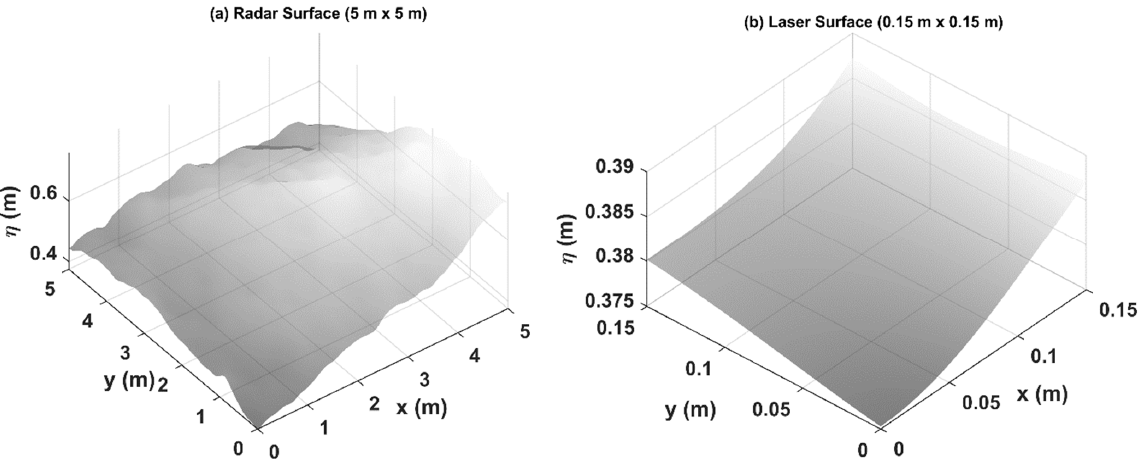
Figure 1. Examples of water surface regions simulated using linear (Fourier) numerical modeling approximately covered by the footprints of ( a ) the Radar (5 m × 5 m ) and ( b ) the Laser (0.15 m × 0.15 m ) beams.